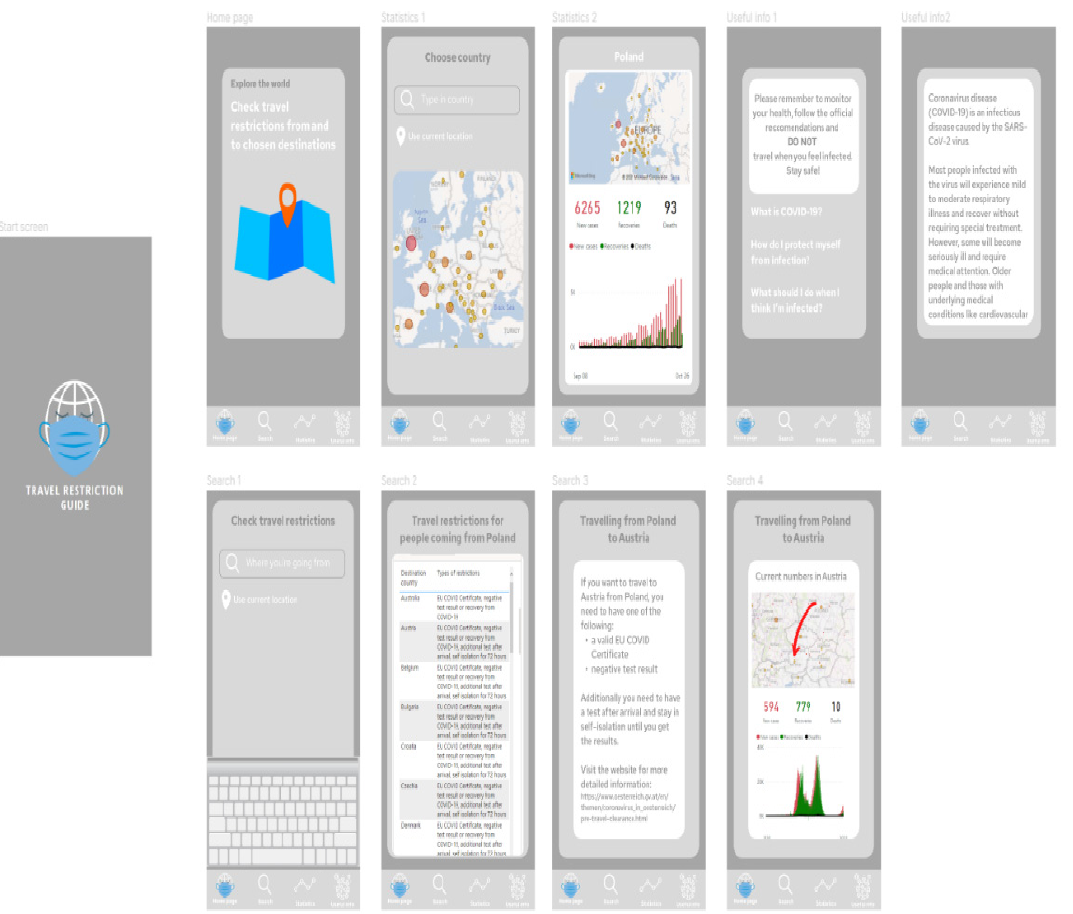
Figure 7. Project of the application screens—general view, showing all screens prepared in the prototype, starting from the home screen, choosing the location, Power BI report embedded in the application, additional information and statistics regarding COVID-19 in the chosen location, and table with travel restrictions. Source: Authors own elaboration.